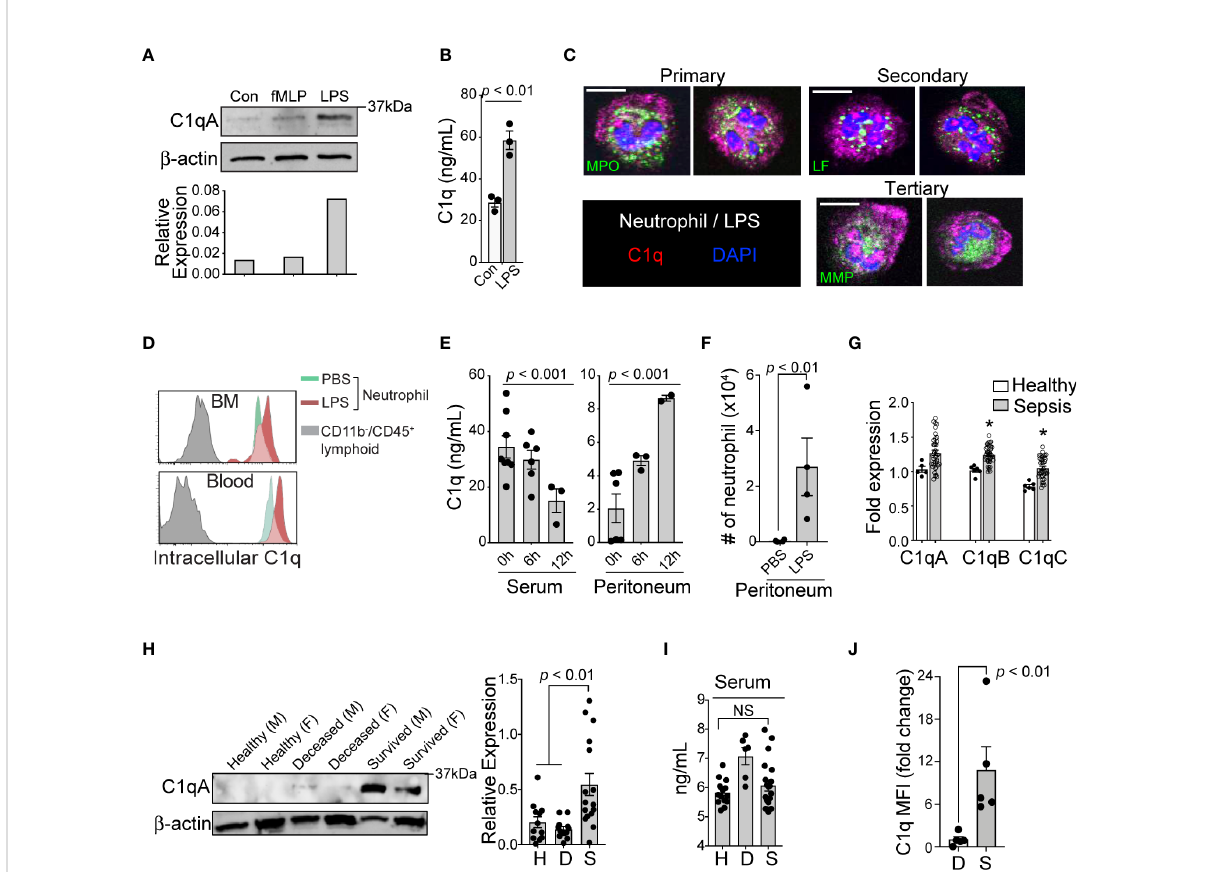
FIGURE 2 Loss of C1q expression represents the functional heterogeneity of neutrophil that are associated with sepsis mortality. (A) , Top: Western blot analysis of C1q expression in healthy human neutrophils after stimulation with fMLP (10 m M) or LPS (10 m g/mL) for 1h (representative of three subjects), bottom: densitometry quanti fi cation. (B) , Total C1q secretion of healthy human neutrophils stimulated with LPS (10 m g/mL) for 1h in vitro . (C) , Immuno fl uorescence image of human neutrophils stained with Abs against C1q (red), myeloperoxidase (MPO, green), lactoferrin (LF, green), and MMP-9 (MMP, green). Scale bar, 10 m m. (D) , Representative MFI histograms of C1q expression from the bone marrow (BM) and circulation of CD45 + /CD11b + /Ly6G/C + neutrophils ( green peaks = PBS, red peaks = LPS) versus CD45 + /CD11b - lymphoid cells ( grey peaks). (E) , Total C1q secretion in the serum ( left ) and peritoneum ( right ) during acute systemic in fl ammation at 6 and 12h as measured by ELISA. (F) , Absolute neutrophil counts from peritoneal lavage isolates in PBS vs LPS treated mice (n = 4 mice each). (G) , qPCR of C1qa, C1qb, and C1qc in healthy subjects (n = 5-6) and septic patients (n=22) as compared to three averaged housekeeping genes. (H) , Left , C1q (weight = 29Da) western blot analysis on neutrophils isolated from healthy (H), deceased (D), and survived (S) sepsis patients. M, male; F, female; Data representative of six experiments. Right , quanti fi cation of total C1q protein expression by western blot in healthy (H), deceased (D), and survived (S) patient neutrophils (n = 12, 12, and 16, respectively). (I) , Total serum C1q of healthy (H), deceased (D), and survived (S) patients measured by ELISA (n = 14, 6, and 20, respectively). NS, Not signi fi cant. (J) , C1q levels in neutrophils from the peritoneal lavage of septic mice were analyzed by fl ow cytometry (n = 4 mice/group). Data are presented as mean ± SEM. Data were analyzed by ordinary one-way ANOVA with Tukey ’ s multiple comparison post-test in (E, H, I) , by students t-test for (B, J) , and by Welch ’ s t-test for two-group comparison for (G)